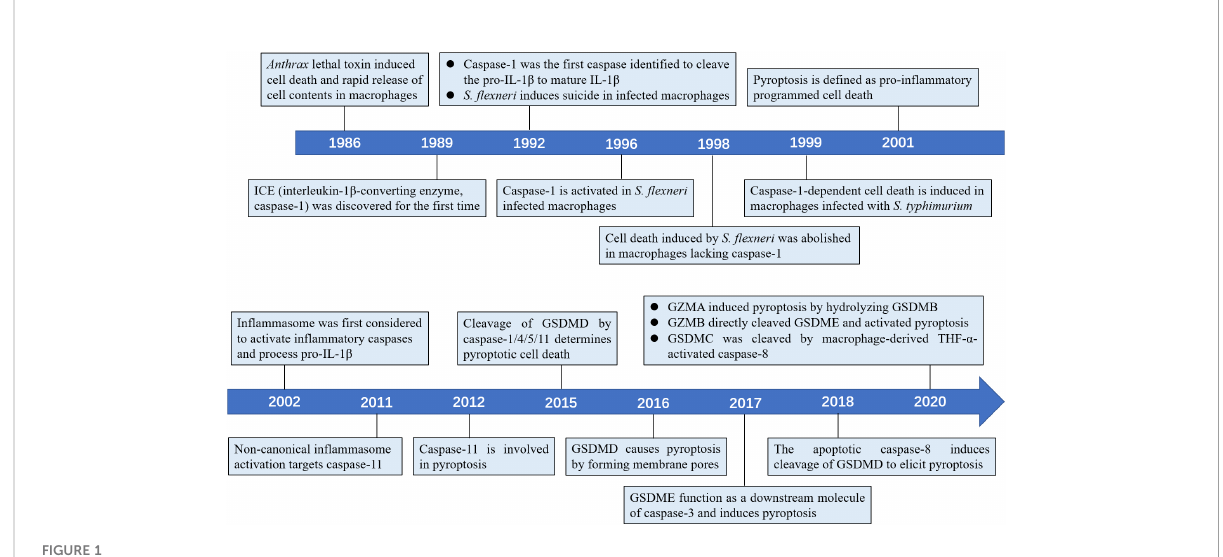
FIGURE 1 Timeline of the key discoveries about the